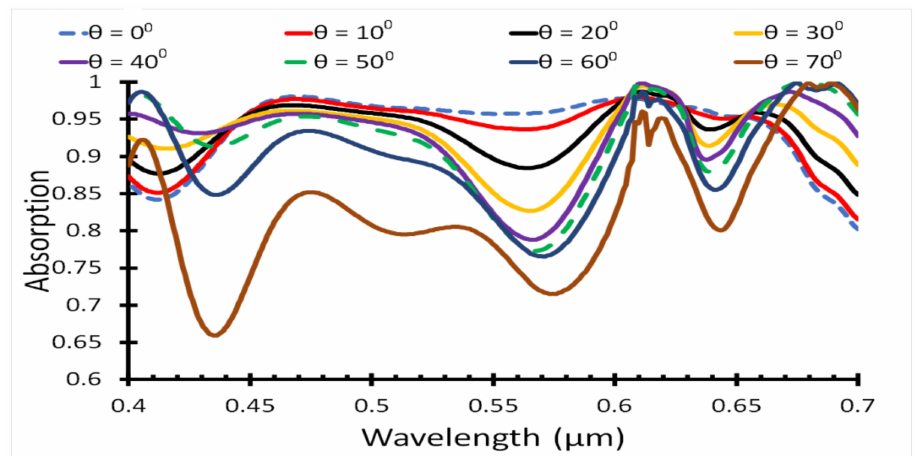
Figure 8. Absorbed light in the active region for different incident angle.